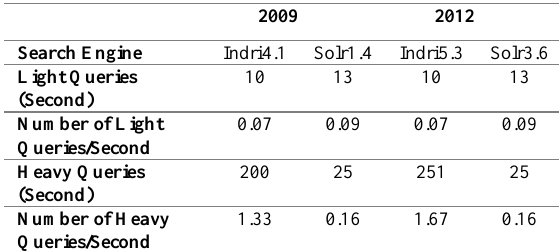
Table 7. Comparison of search time in Solr and Indri.